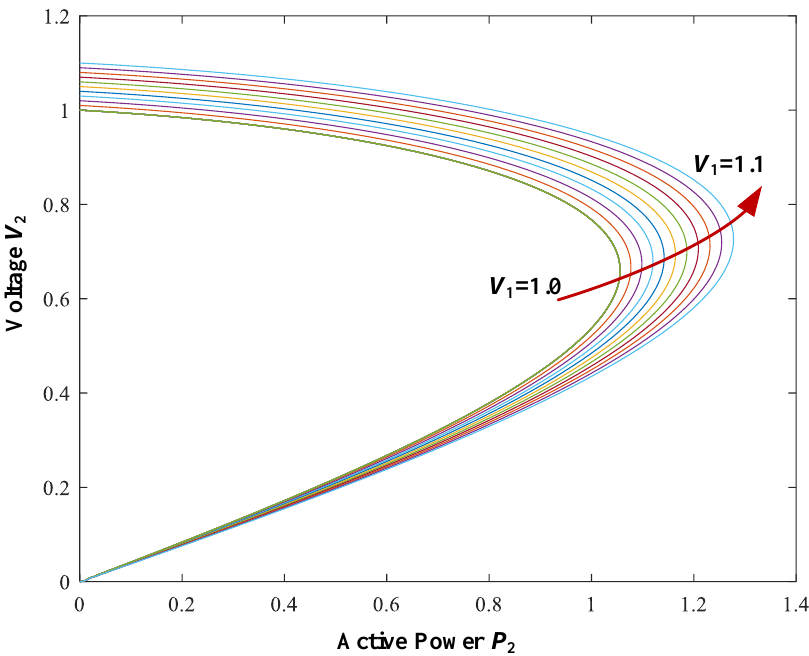
Figure 9. P-V curve of step-less voltage regulation process with Flexible OLVR transformer.